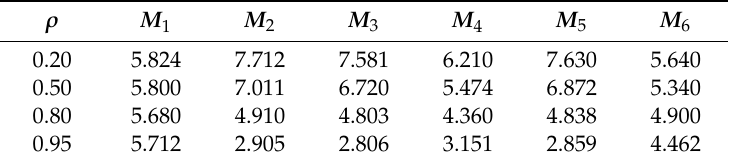
Table 2. Control chart multipliers ( K a ) for obtaining α = 0.01 using n = 10 at di ff erent levels of ρ